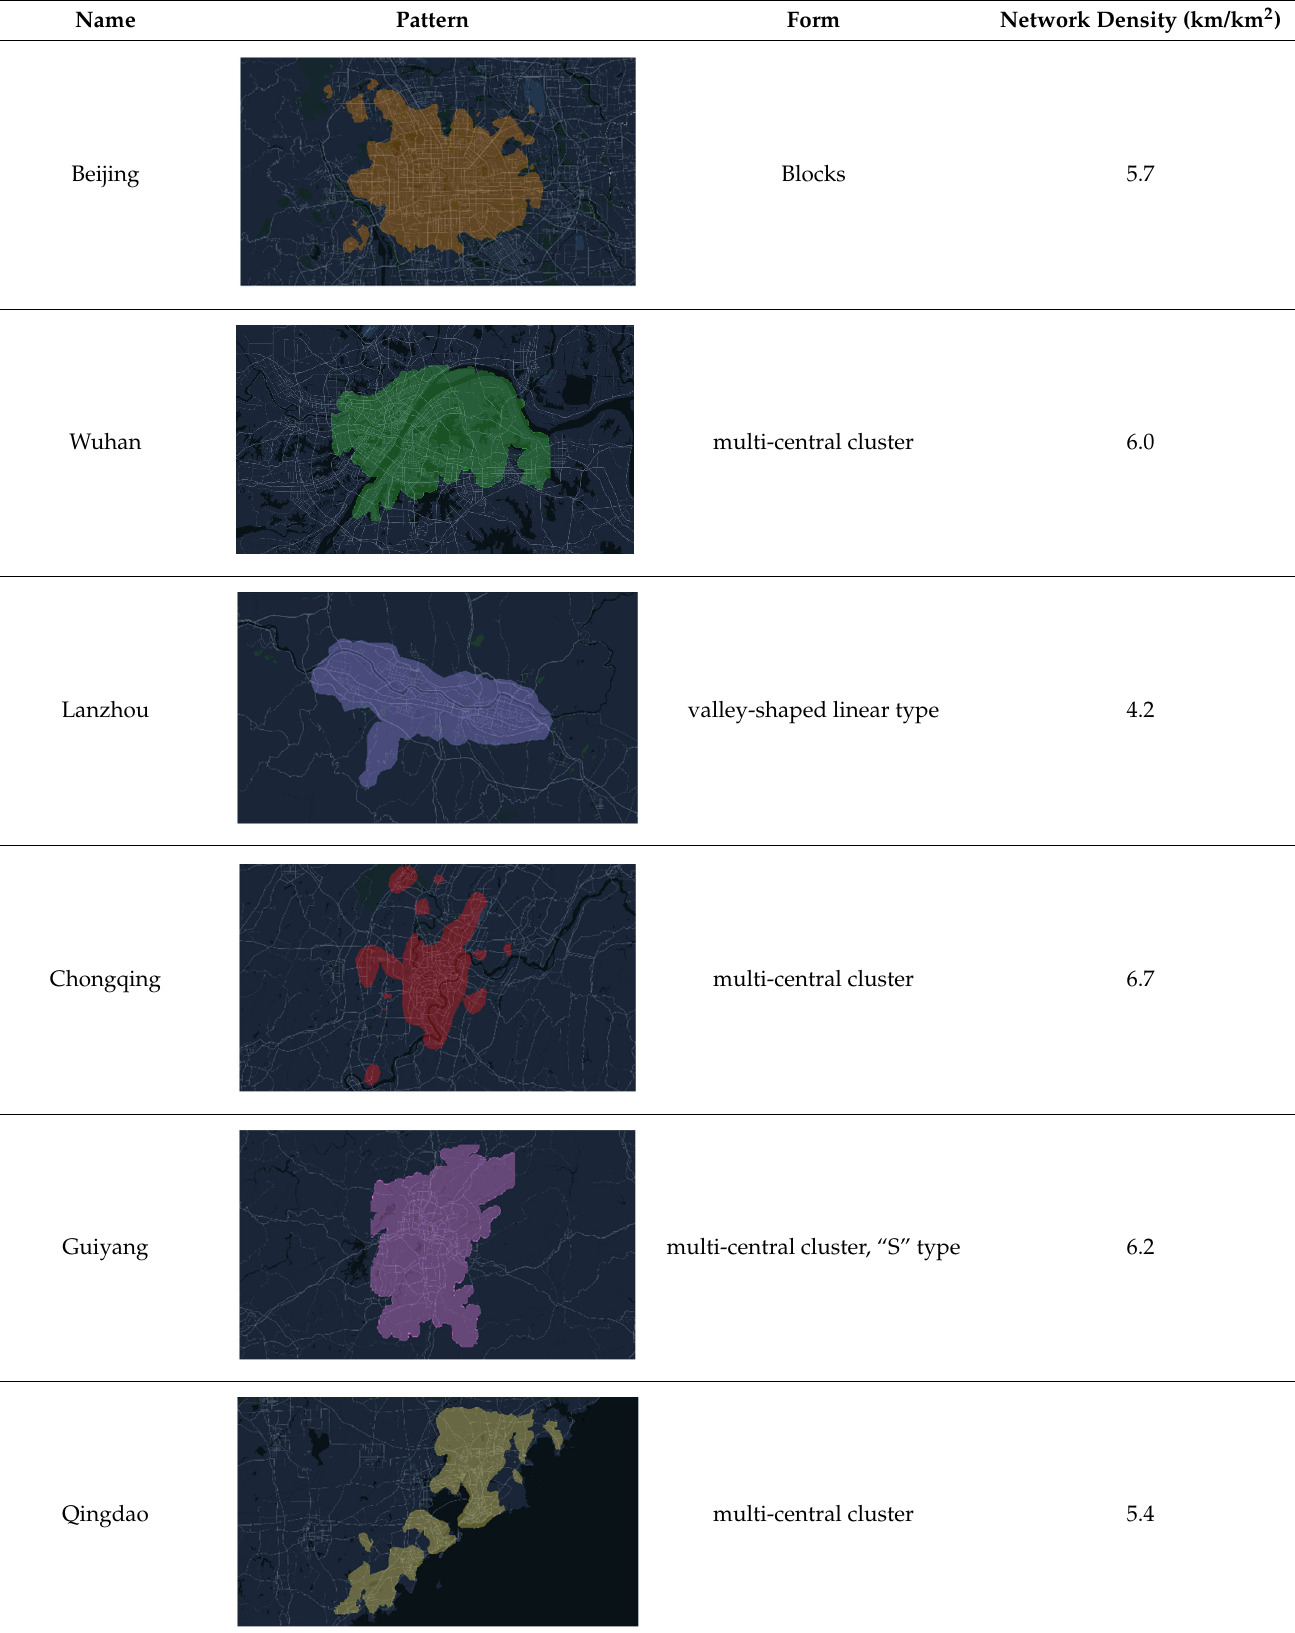
Table 2. Characteristics of typical cities and their road network.